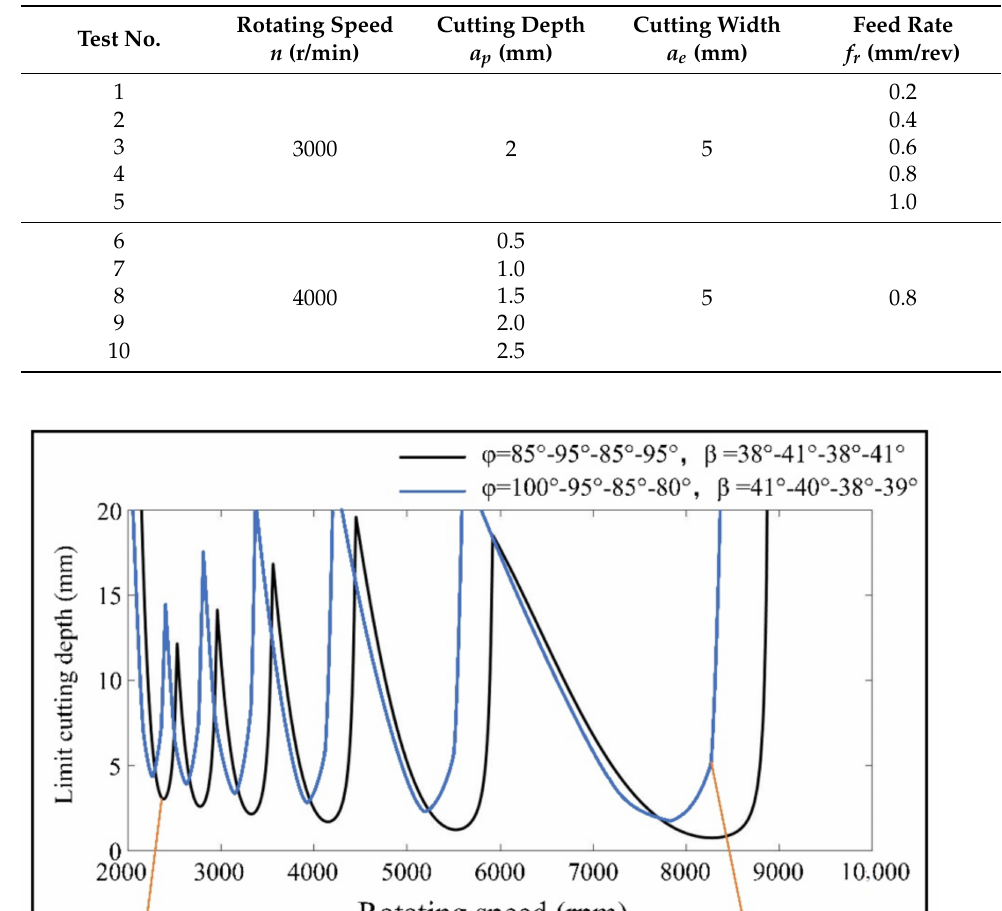
Table 1. Testing plan.